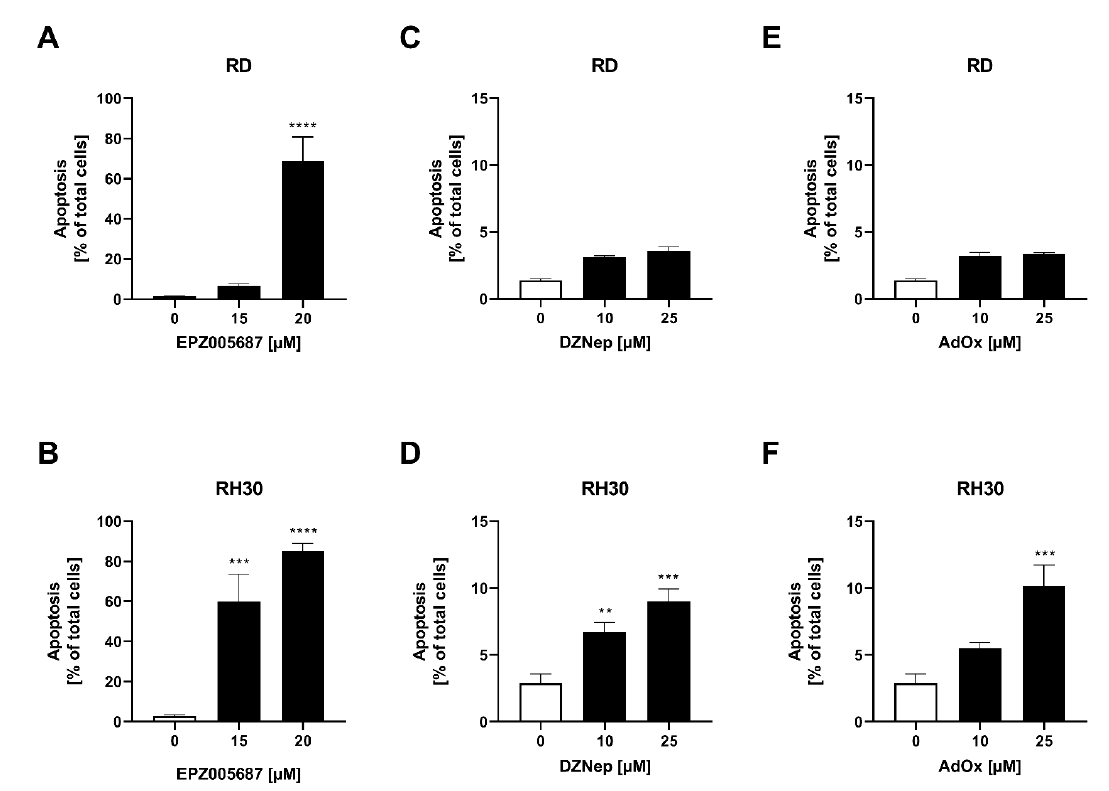
Figure 5. Flow cytometric analysis of apoptosis in RMS cells after treatment with EZH2 inhibitors. Arithmetic means ± SEM ( n = 3) of the number of Annexin V-positive cells after 72 h incubation with EPZ005687 ( A , B ), DZNep ( C , D ), and AdOx ( E , F ) in RD cells (upper row) and in RH30 (lower row) cells. The untreated control was set as 100%. p ** ≤ 0.01, p *** ≤ 0.001, p **** ≤ 0.0001 indicates statistical significance.